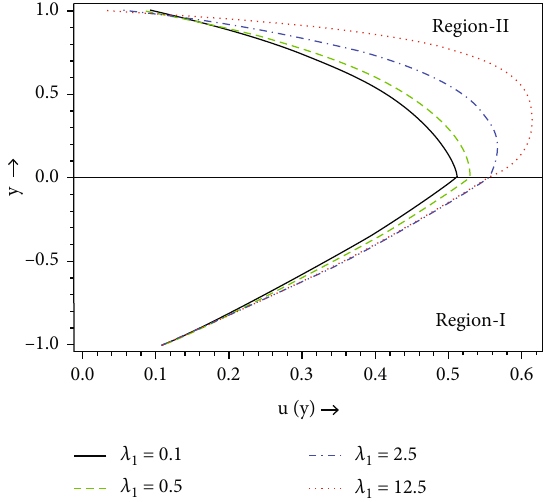
Figure 3: Variation of velocity pro fi le with Je ff rey parameter λ